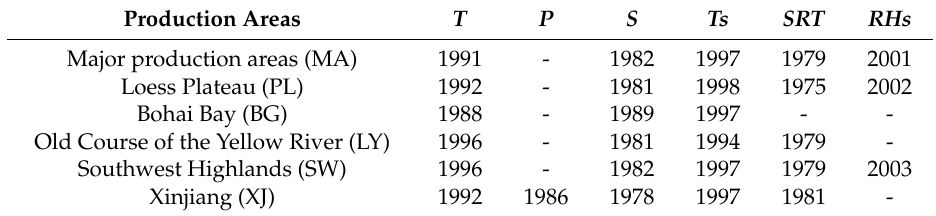
Table 3. The abrupt change analyses of the major climate factors affecting apple quality in China using the Mann-Kendall method ( α =